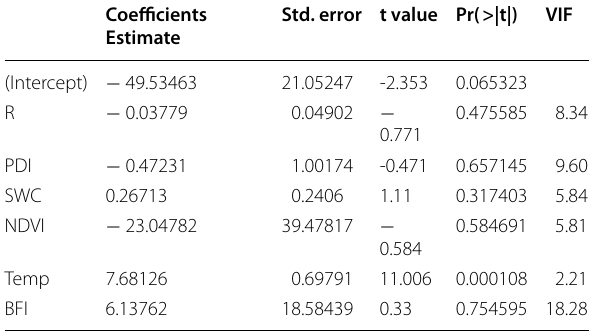
Table 6 Statistic results of the full regression model for mean monthly PET Coefficients Estimate